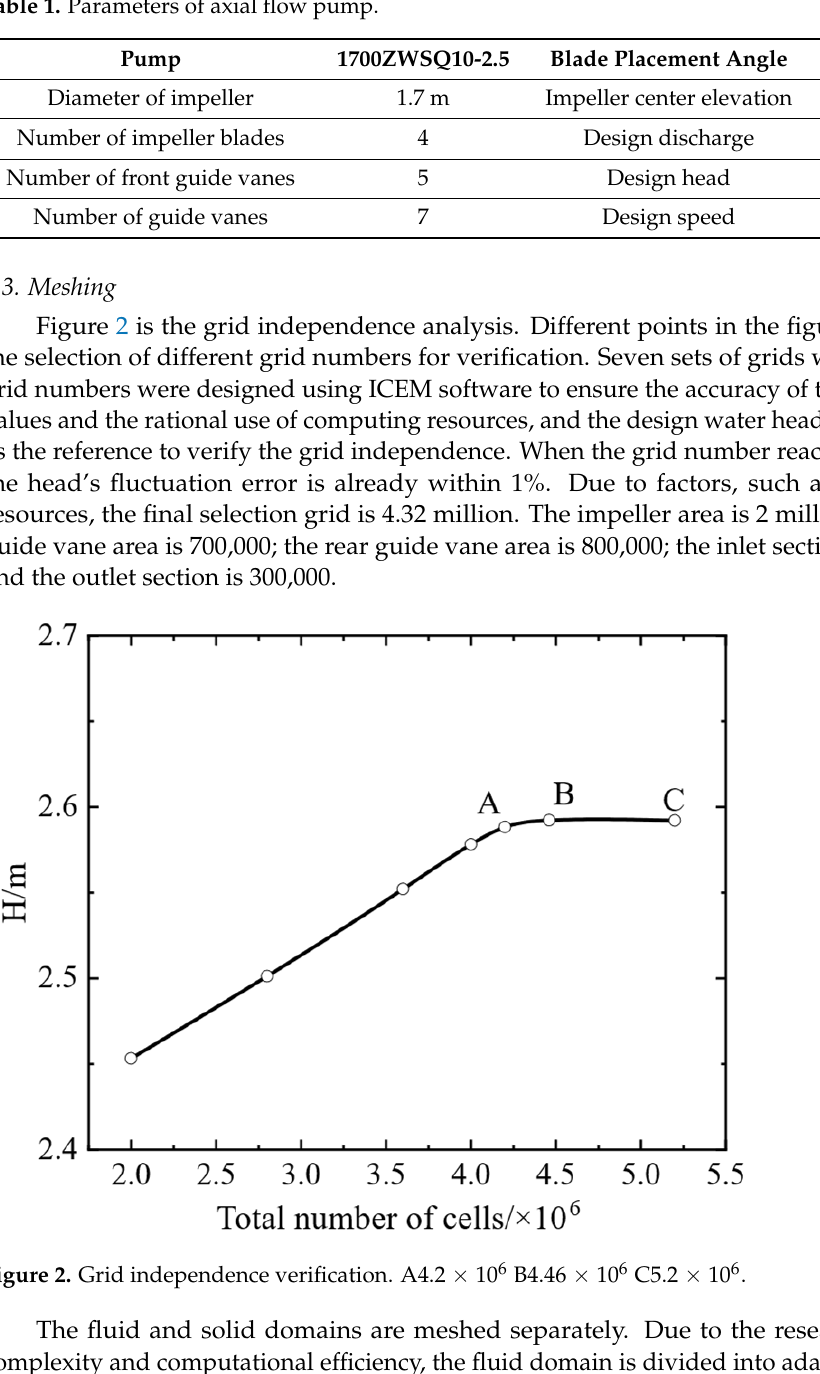
The fluid and solid domains are meshed separately. Due to the research model’s complexity and computational efficiency, the fluid domain is divided into adaptive meshes, and the runner blades are locally refined. The solid domain was meshed using the meshing module of the workbench platform, and an adaptive tetrahedral mesh divides the structure. Five mesh sizes were selected: 0.2, 0.1, 0.08, 0.02, and 0.002 m. The verification found that when the grid size reaches 0.02 m, the stress amplitude fluctuation is within 2%. When the grid size reaches 0.002 m, the stress fluctuation is not evident, and the number of structural grids is significant, requiring enormous computing resources. Therefore, a mesh size of 0.02 m was selected for solid domain meshing. Figure 3 shows the meshing of part of the fluid computing domain. Different colors are used to show different parts of the fluid computing domain, especially the blade